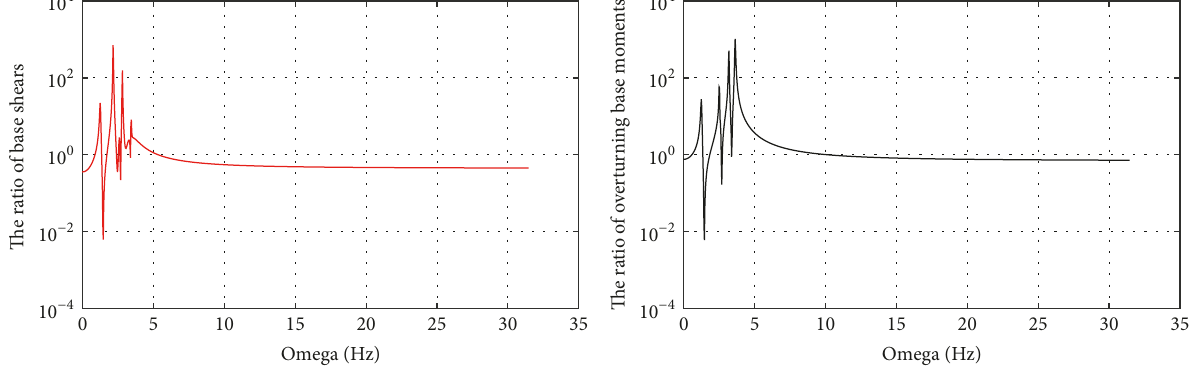
Figure 7: Curves of the ratios of the base shears and the overturning base